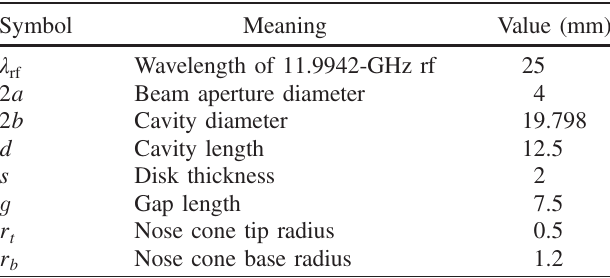
TABLE V. Design parameters of Fig. 7.